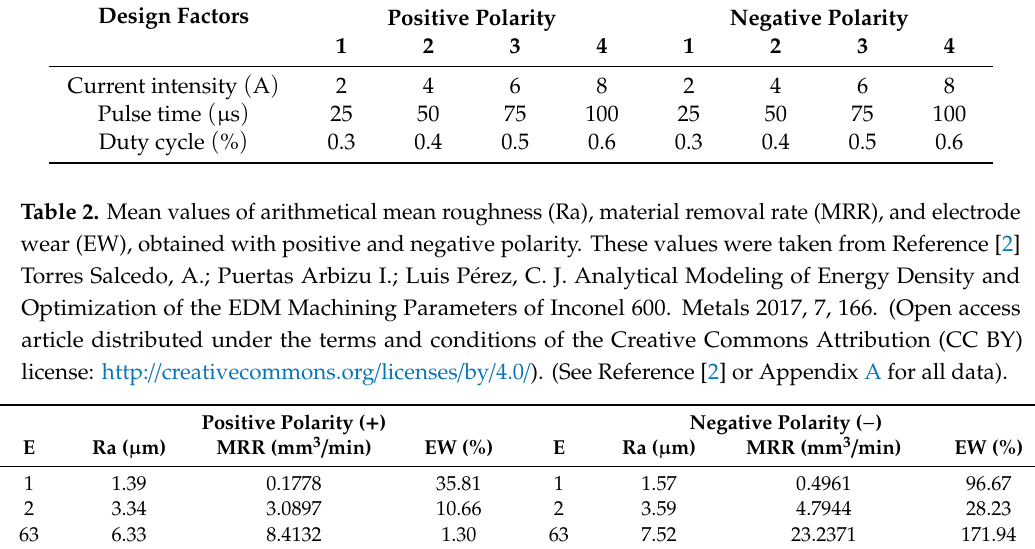
Table 1. Design factors and levels. These values were taken from Reference [2] Torres Salcedo, A.;